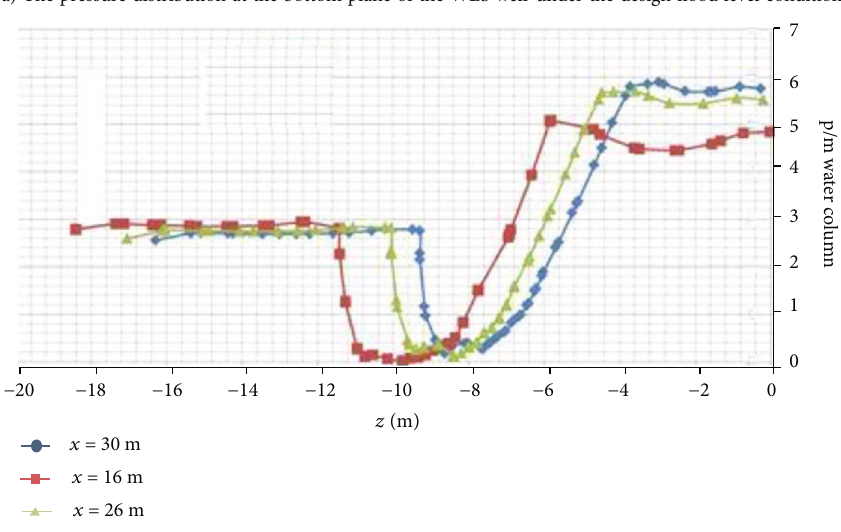
Figure 11: The pressure distribution in the WES weir.